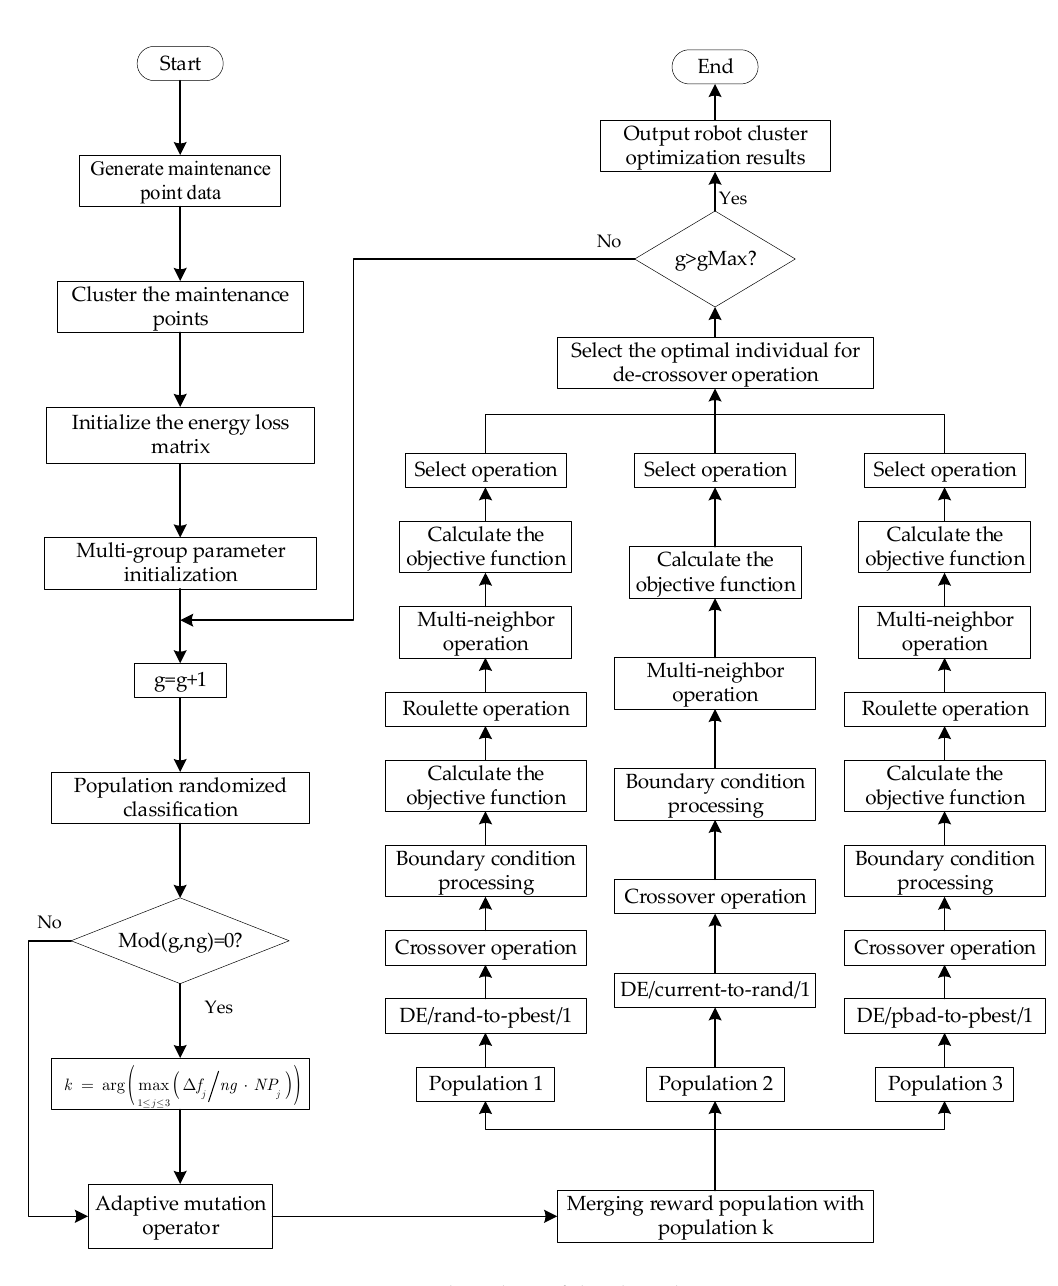
Figure 2. Flow chart of the algorithm.